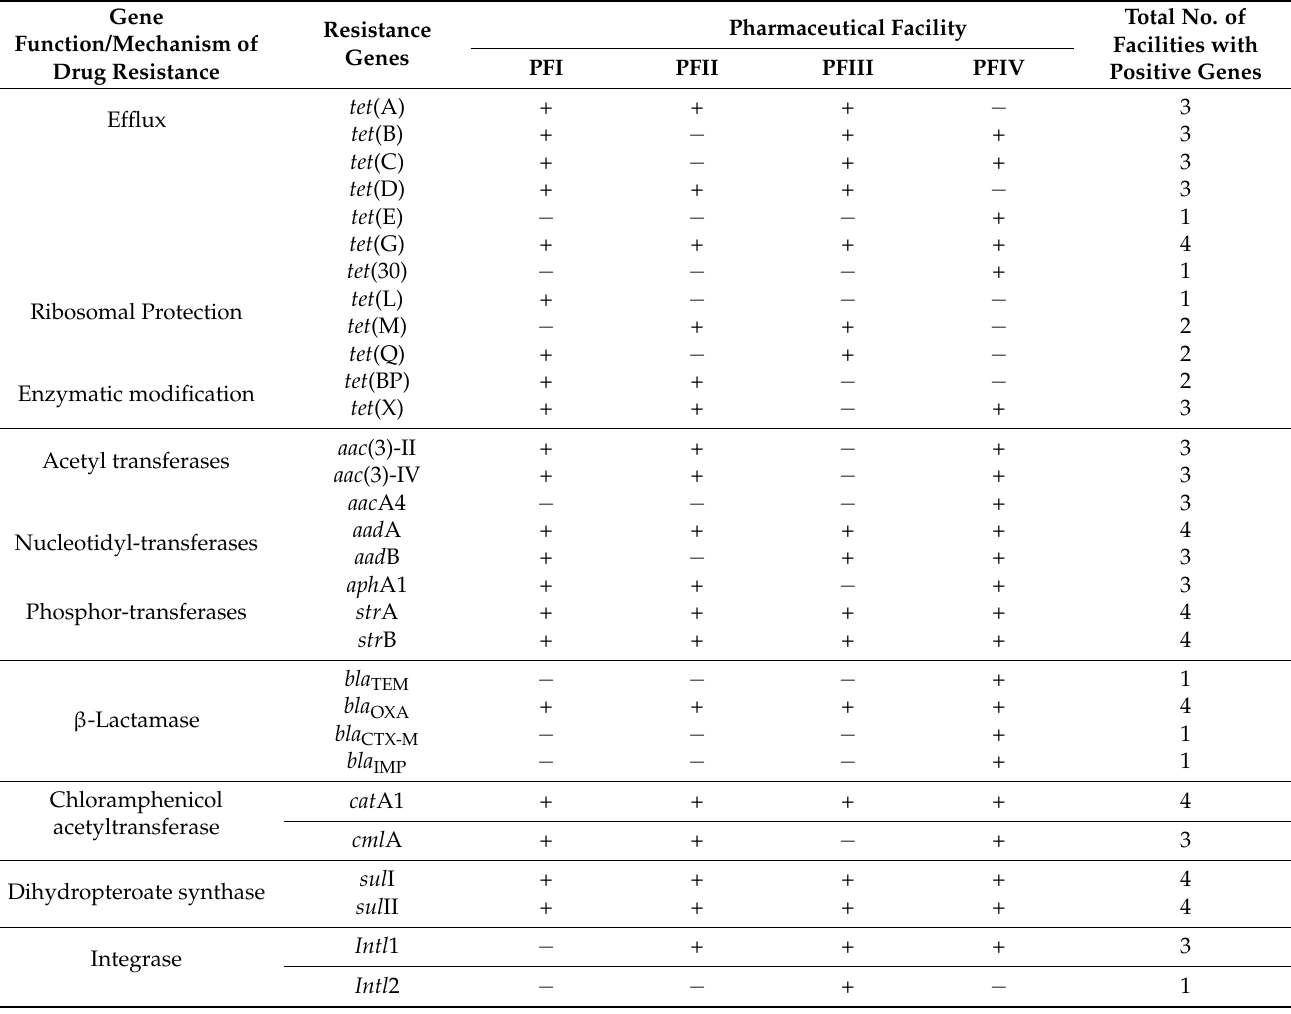
Table 1. Distribution of selected antibiotics resistance genes from pharmaceutical wastewater.